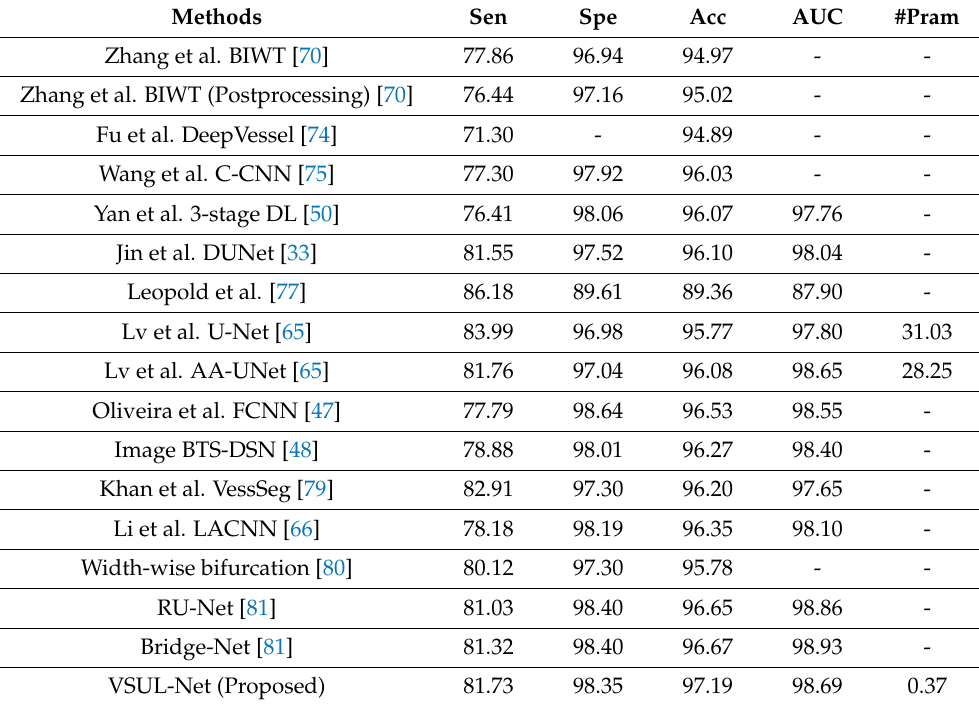
Table 7. Numerical comparison of the proposed VSUL-Net with existing methods for the CHASE- DB1